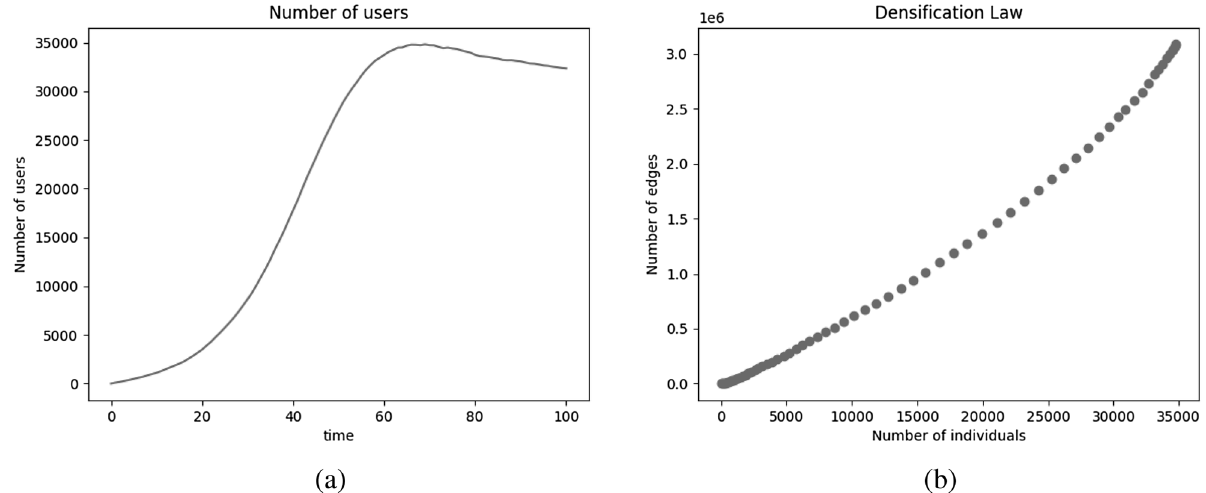
Figure 2. ( a ) Number of individuals and ( b ) number of edges of undirected networks generated using selected